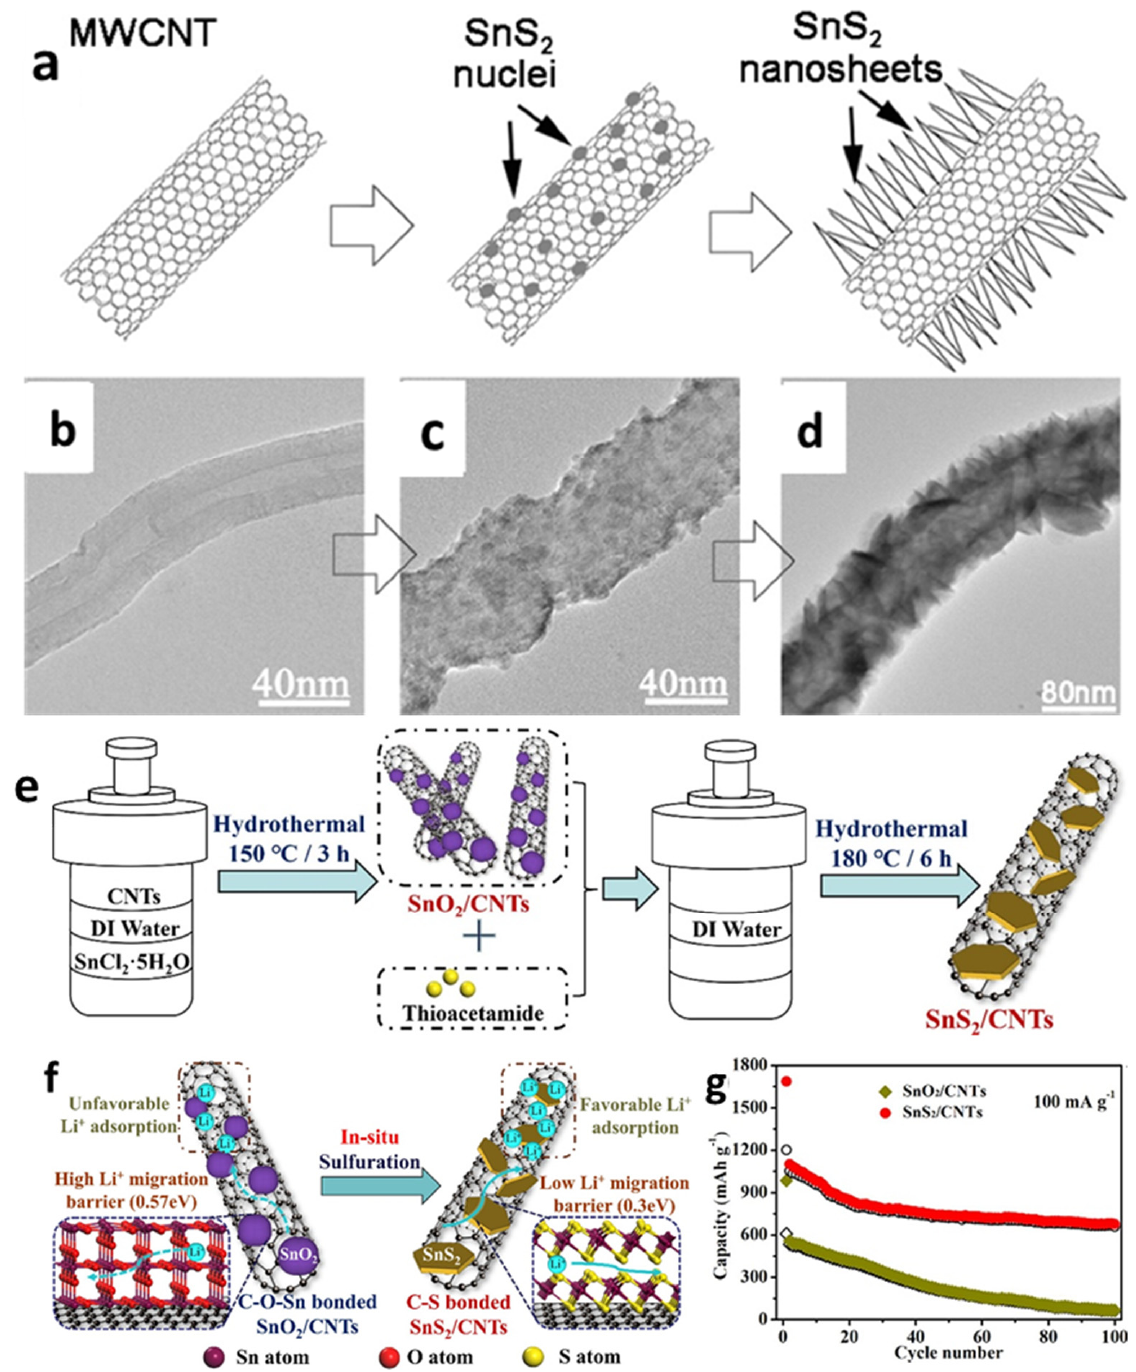
Figure 4. ( a ) Schematic illustration for the growth process of the SnS 2 NS@MWCNTs and ( b – d ) their TEM images. Reprinted with permission from Ref. [126]. Copyright 2011 ACS. ( e ) The synthesis procedures diagram; ( f ) illustration of the Li storage advantage; ( g ) cycling performance of the SnS 2 /CNTs composite. Reprinted with permission from Ref. [48]. Copyright 2021